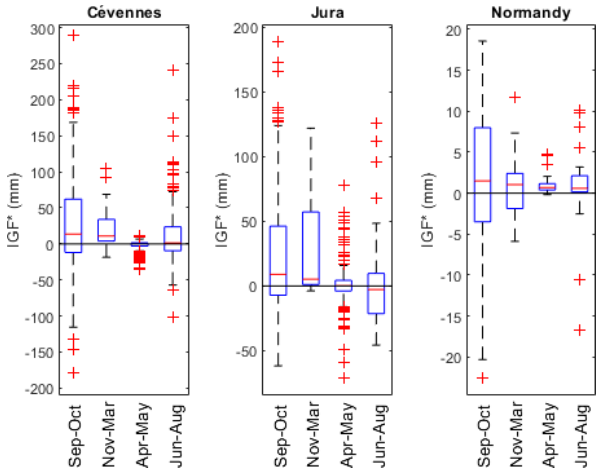
Figure 8. IGF ∗ depth distributions for the three studied sites, ac- cording to